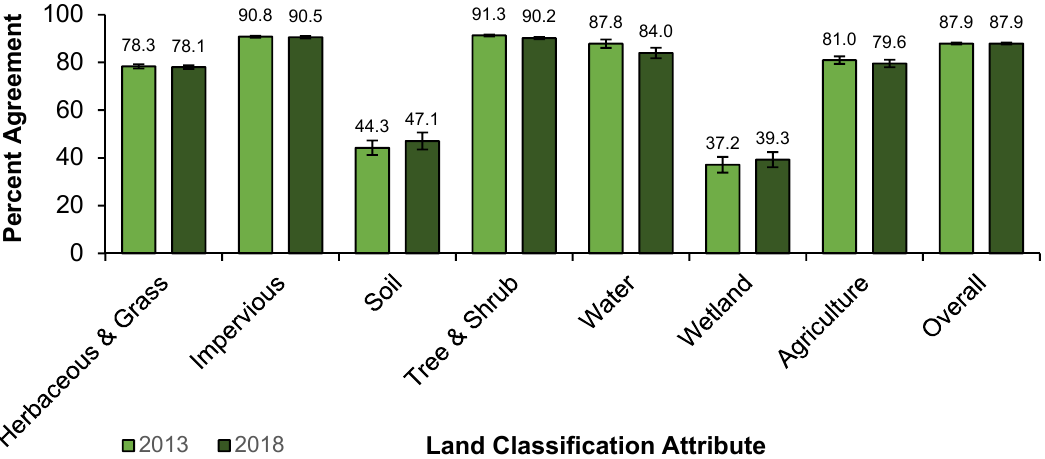
Figure 5. Assessors’ agreement for landcover classifications over two assessment time periods. (n = 404).